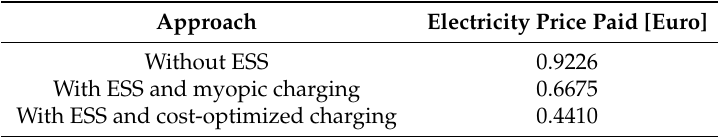
Table 3. Price comparison between different approaches for Scenario 2.